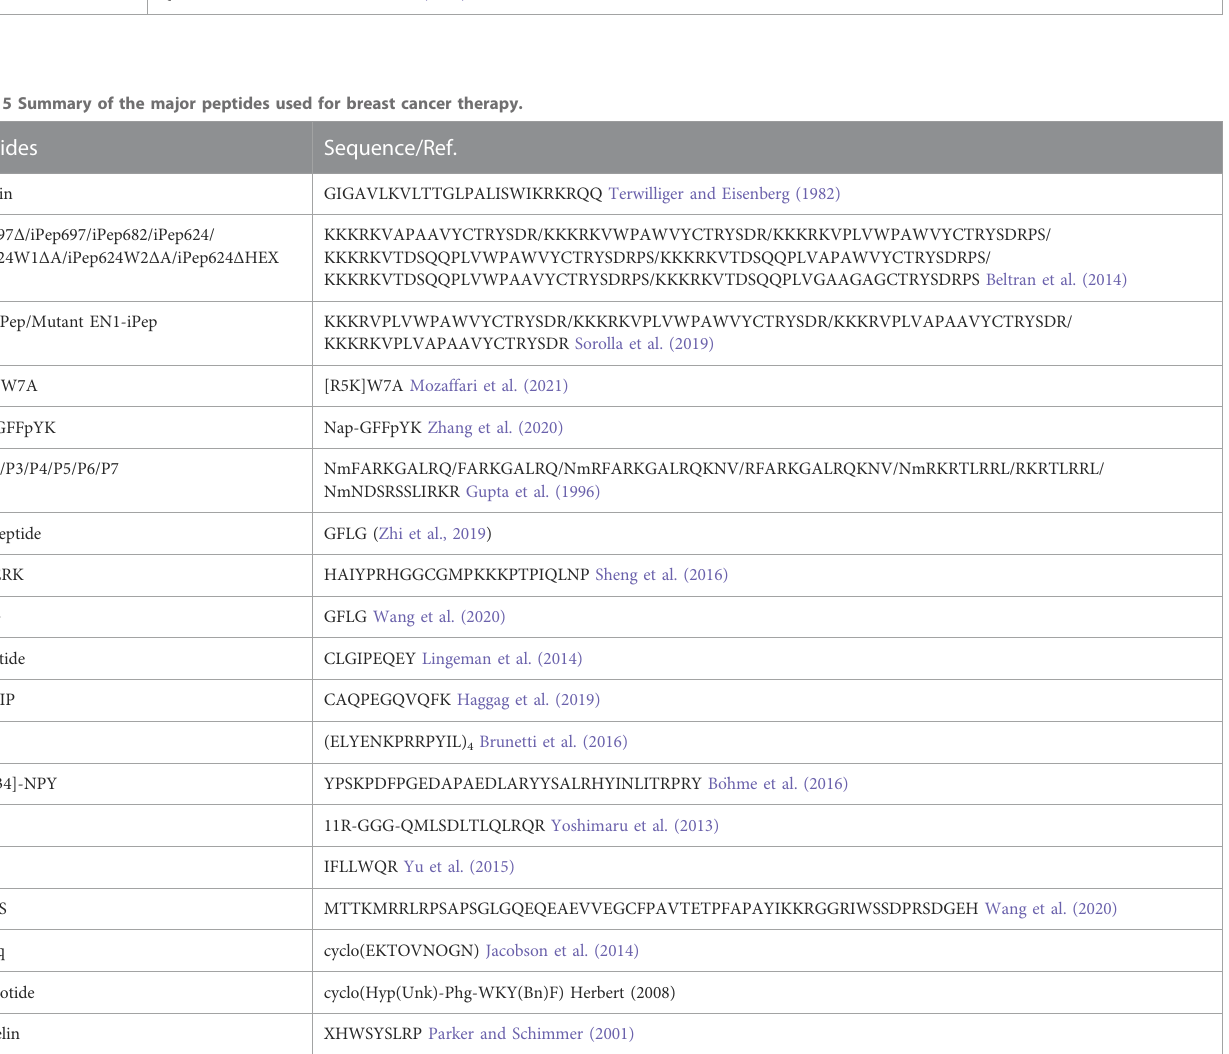
XIGGIG) (the “ X ” represents any of 20 amino acids) (Servín-Blanco